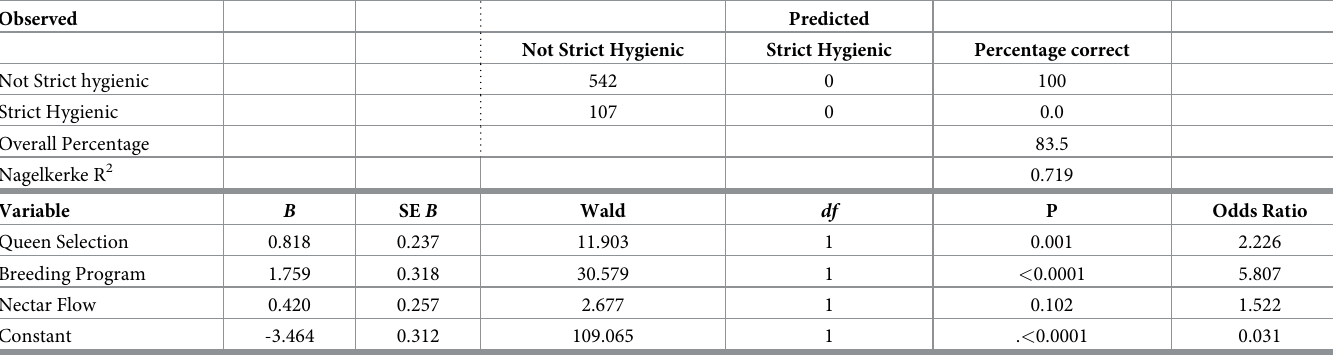
Dependent variable: strict hygienic behaviour. Predictor variables: queen selection, breeding program, and nectar